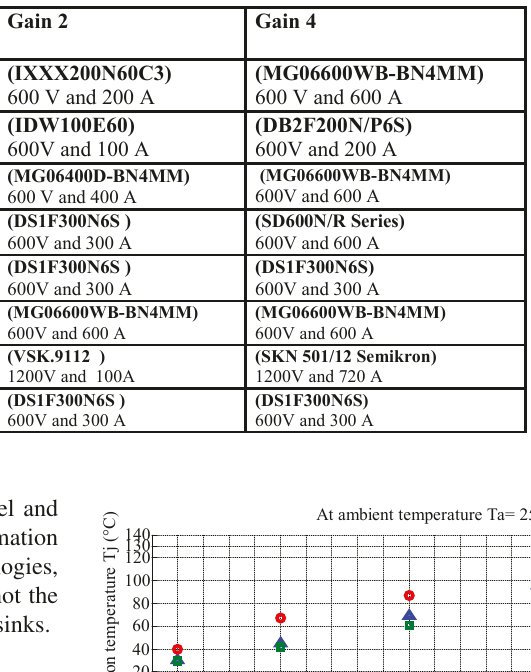
TABLE III. Semiconductor devices selection for the three converters and their different voltage gains.